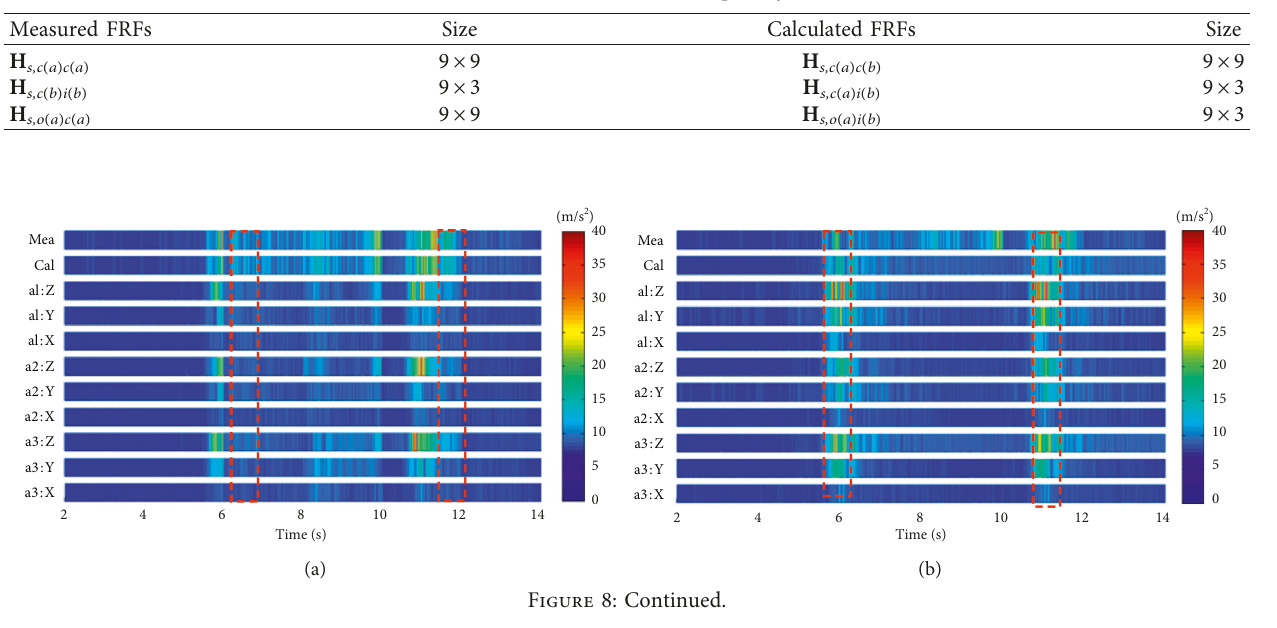
Table 5: FRFs matrix in the coupled system.